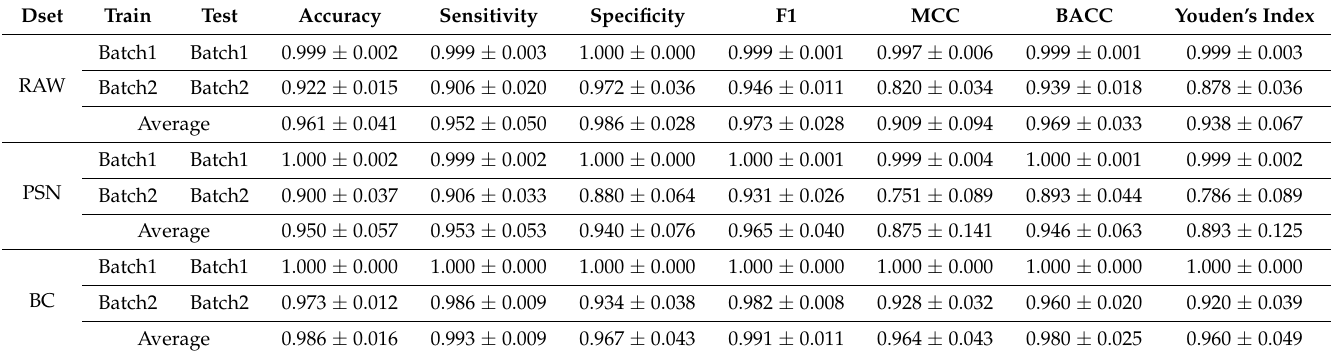
Table 4. Ten-folds cross validation performance using same batch